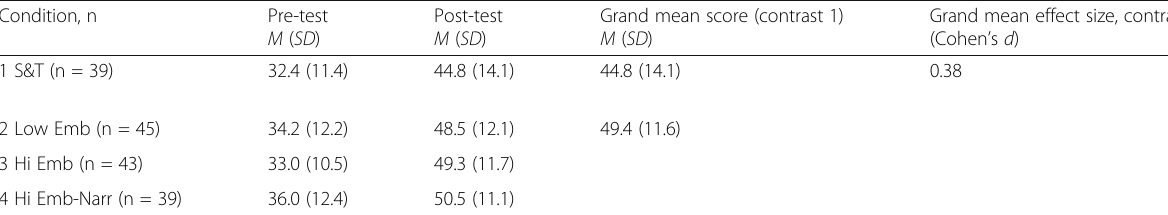
Table 3 Means scores for post-test content knowledge with keyboard Condition, n